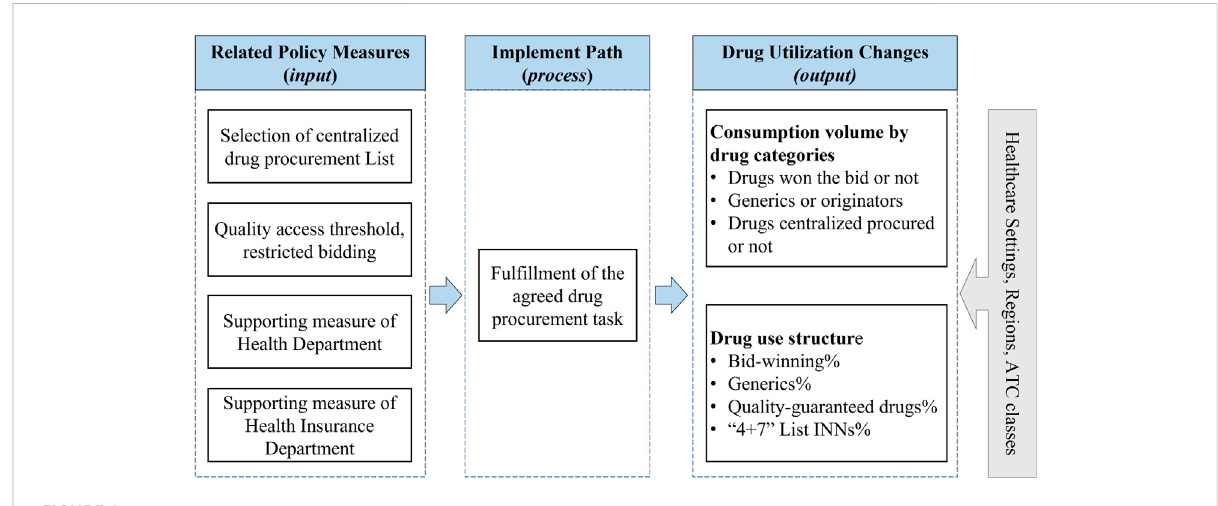
FIGURE 1 Research framework. Note: ATC, anatomical therapeutic